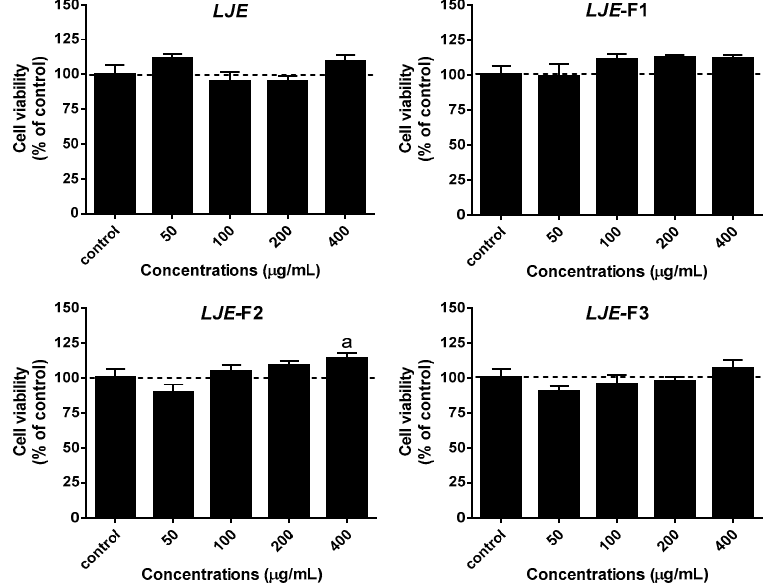
Figure 2. E ff ects of LJE and LJE-Fs on Caco-2 cell viability. Caco-2 cells (1 × 10 5 cells / well) were seeded Figure 2. Effects of LJE and LJE-Fs on Caco-2 cell viability. Caco-2 cells (1 × 10 5 cells/well) were seeded in a 24-well plate and treated with LJE or LJE-Fs (0, 50, 100, 200, or 400 µ g / mL) for 24 h. Values